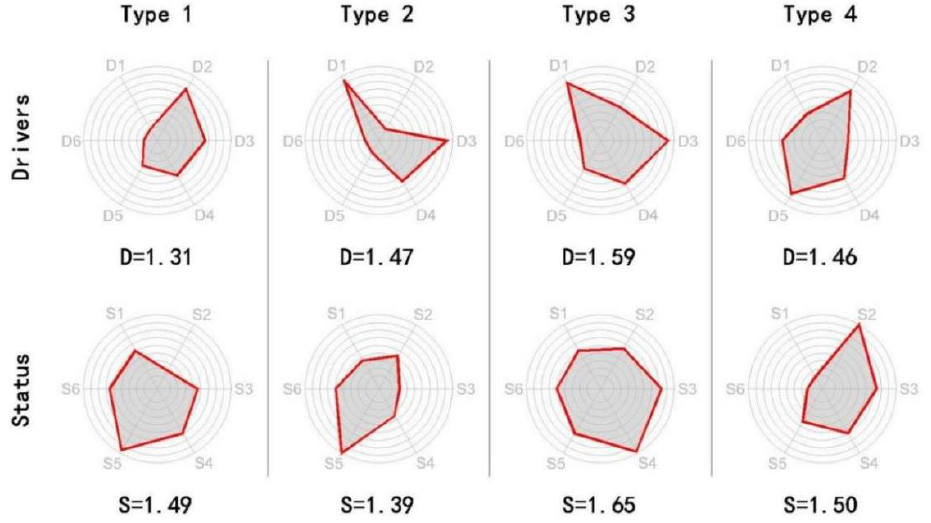
Figure 6. Radar chart analysis on the attributes of UPS types.